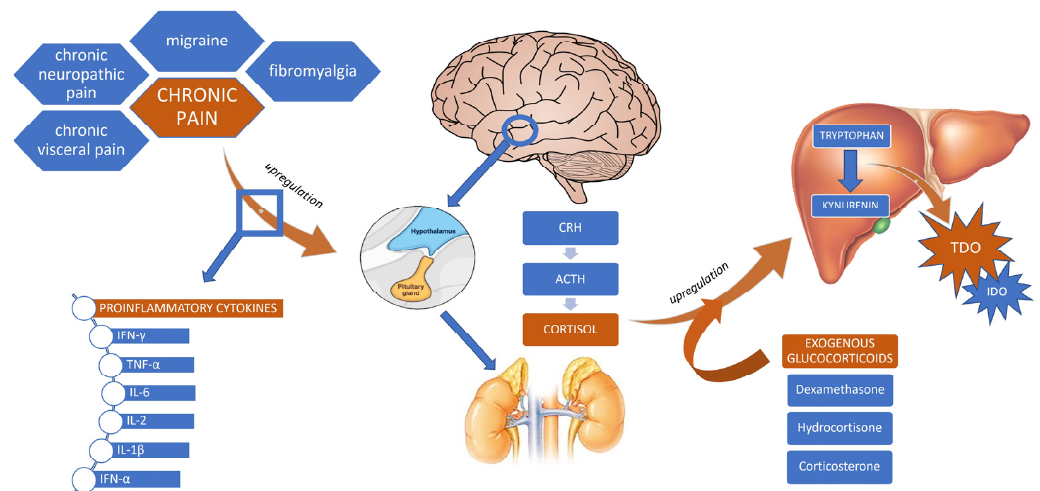
Figure 2. Cortisol and exogenous glucocorticoids as modulators of the KP in different chronic pain conditions. Abbreviations: IFN- γ , interferon- γ ; TNF- α , tumor necrosis factor- α ; IL-6, interleukin-6; IL-2, interleukin-2; IL-1 β , interleukin-1 β ; IFN- α , interferon- α ; CRH, corticotropin-releasing hor- mone; ACTH, adrenocorticotropic hormone; TDO, tryptophan 2,3-dioxygenase; IDO, indoleamine 2,3-dioxygenase.